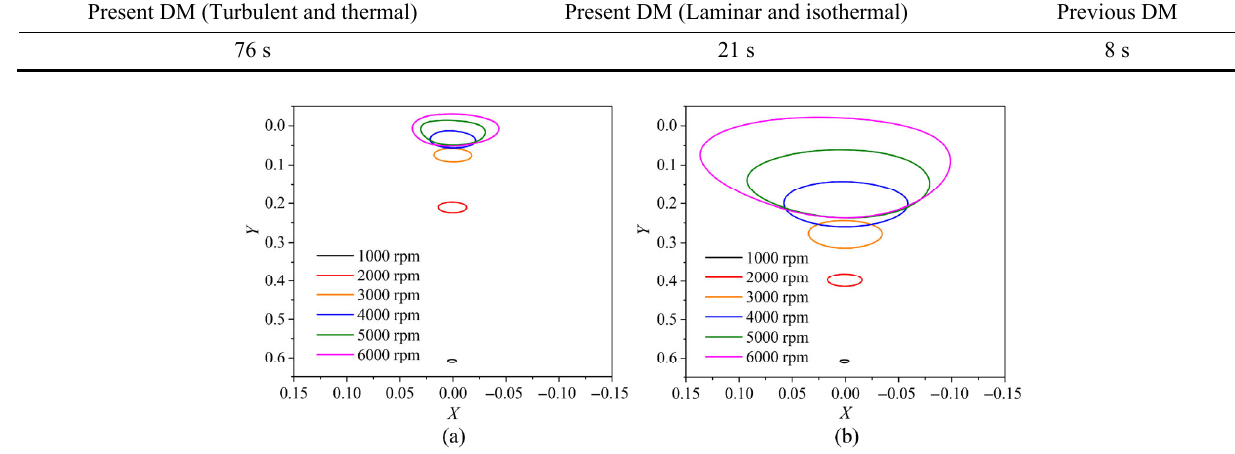
Table 3 Calculation time for ten cycles of transient journal center orbits at 3,000 rpm with the present DM and previous DM. Present DM (Turbulent and thermal)